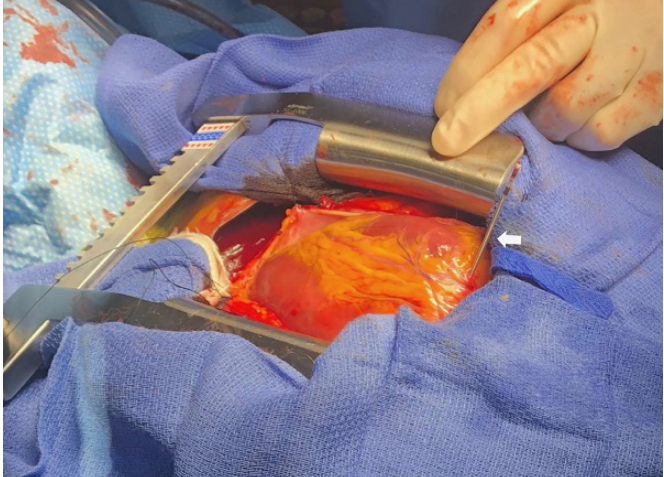
Image 3. Mediastinal exploration via sternotomy revealing ventricular lead piercing through the right ventricular apex